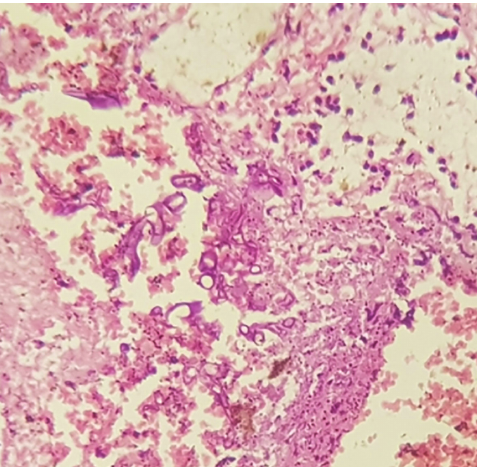
Figure 6d - D, Photomicrograph of a histological examination of necrotic nasal cavity tissue with accumulation of mucormycosis bacilli, mucormycosis fungal hyphae. Hematoxylin and eosin, x200.